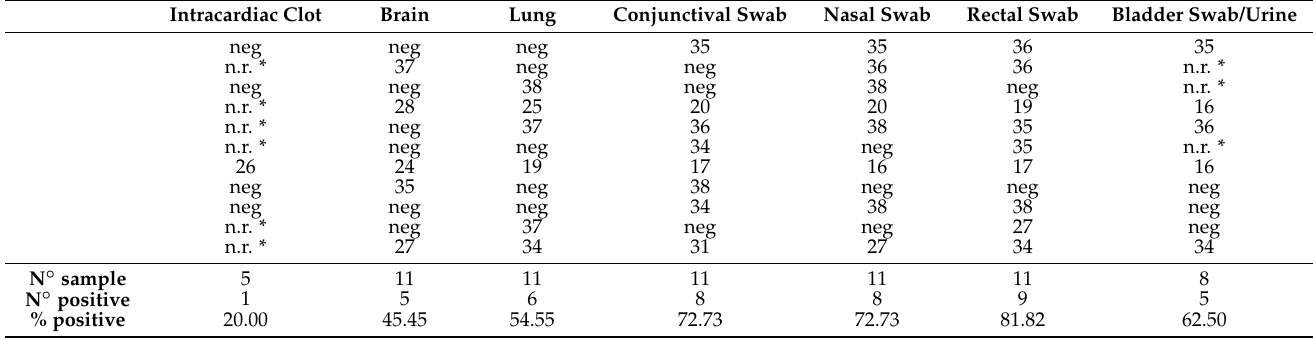
Table 3. Results obtained with Real Time PCR for the different samples of positive subjects relative to 2017–2019 (Ct). Intracardiac Clot